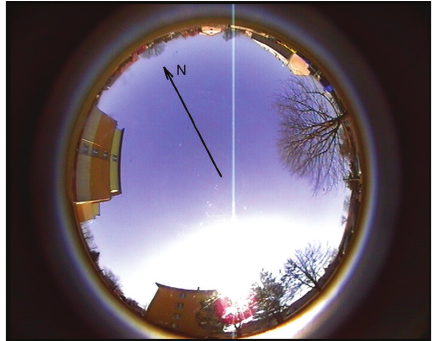
Figure3:Scenario3:thearrowindicatesduenorth(0 deg.azimuth); the azimuth runs in a clockwise